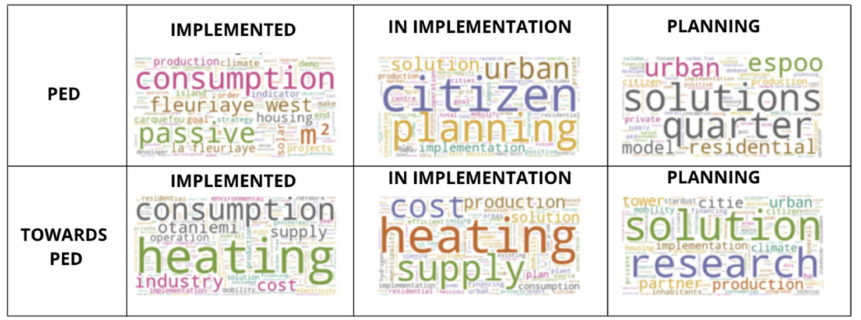
Figure 9. Most commonly used words for PED.